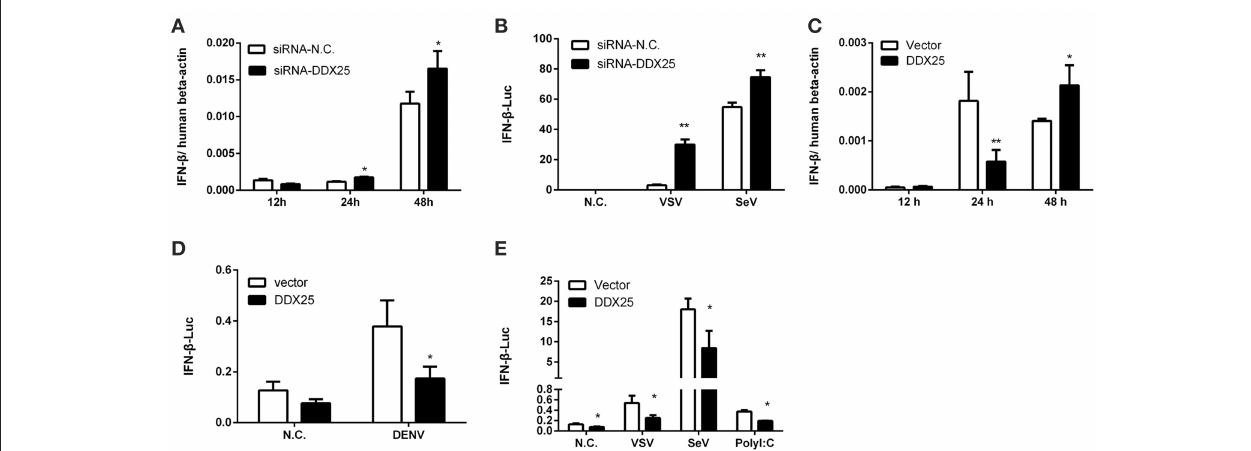
FIGURE 3 | DDX25 negatively regulates IFN β production. (A) qRT-PCR analysis of the mRNA levels of IFN β in HEK293T cells with DDX25 RNAi during DENV infection for 12, 24, and 48 h. (B) VSV and SeV induced IFN β transcriptional activities were enhanced in DDX25 silenced HEK293T cells compared to controls. (C) qRT-PCR analysis of the mRNA levels of IFN β in control and DDX25 overexpressed HEK293T cells during DENV infection for 12, 24, and 48 h. (D,E) Luciferase reporter assay of IFN β transcriptional activity in DDX25 overexpressed HEK293T cells during DENV (D) , VSV, SeV, and Poly I:C (E) stimulation. Results were expressed as the mean + the SEM. * p < 0.05 and ** p < 0.01 ( t -test). Representative results from at least three independent